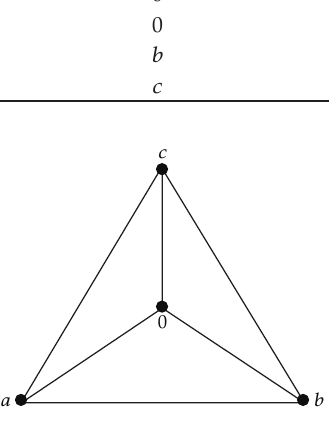
Figure 1: Associated graph Γ(cid:2) X (cid:3) of X